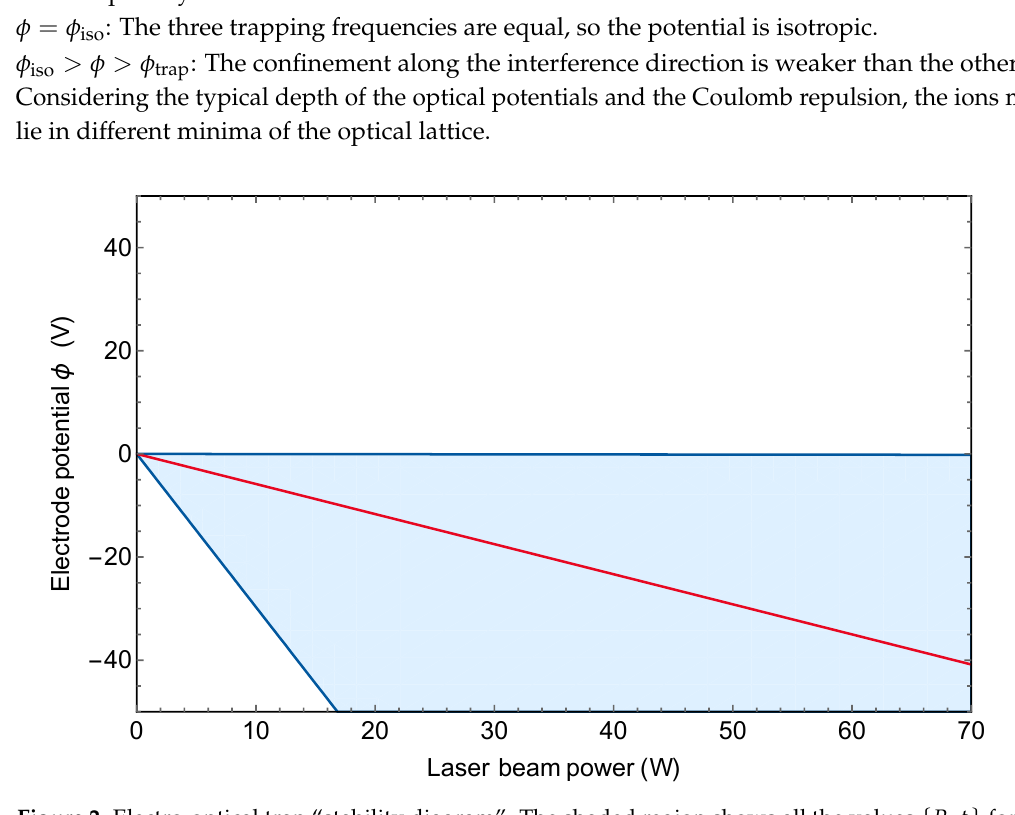
Figure 2. Electro-optical trap “stability diagram”. The shaded region shows all the values { P , φ } for which the trapping frequencies in the three directions are simultaneously positive, thus indicating a stable trapping potential. The laser wavelength, the beam waists, and the crossing angle chosen for trapping Ba + are λ = 451.7nm, w 0 x = w 0 y = 40 µ m, and 2 θ c = 10 ◦ , respectively. The red line indicates the parameters { P iso , φ iso } for which the confinement is equal in each direction. The region above this line corresponds to a disk-like-shaped